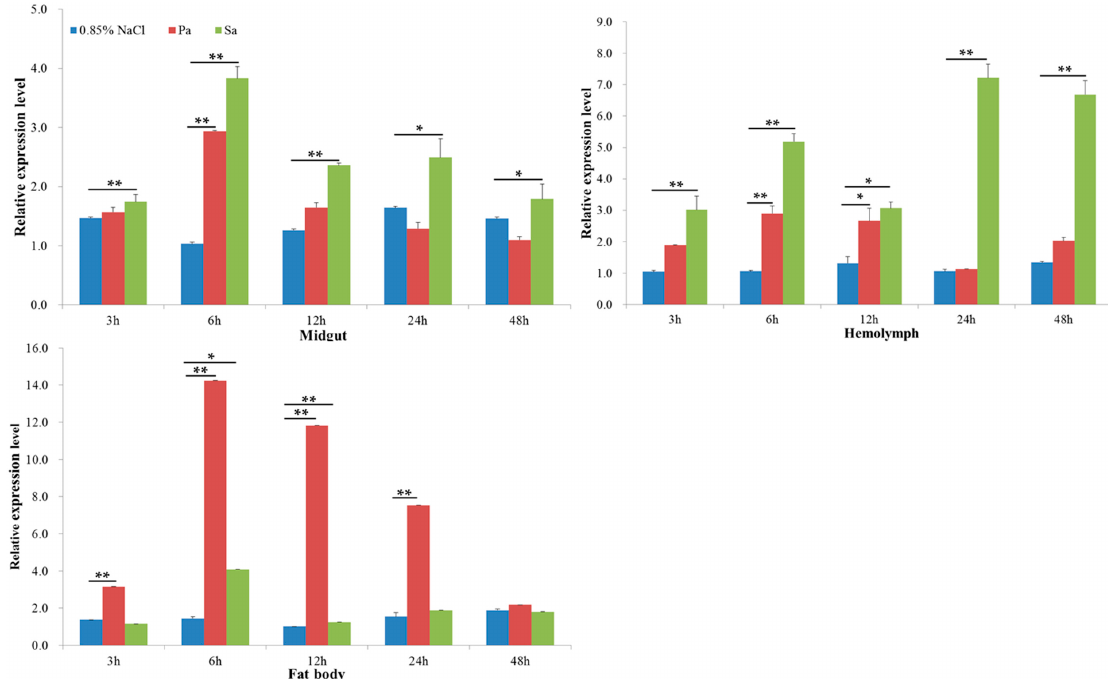
Figure 5. The expression levels of ScFerHCH in the midgut, fat body and hemolymph after injection with P. aeruginosa (Pa) and S. aureus (Sa) at 3, 6, 12, 24 and 48 h. Sterile 0.85% NaCl was used as a control. Relative expression levels were calculated using the 2 −∆∆ C t method. Statistical analysis was performed using the SPSS software. The significant differences are indicated by * ( p < 0.05) or ** ( p < 0.01).